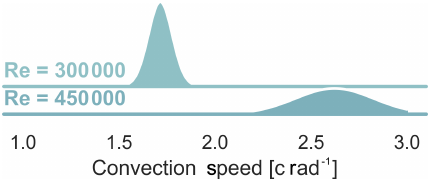
Figure 12. Probability distributions of the convection speed of dy- namic stall with different Reynolds numbers, k = 0 . 09, and α 0 = 18 ◦ , α 1 = 7 ◦ . = 15 ◦ , 0